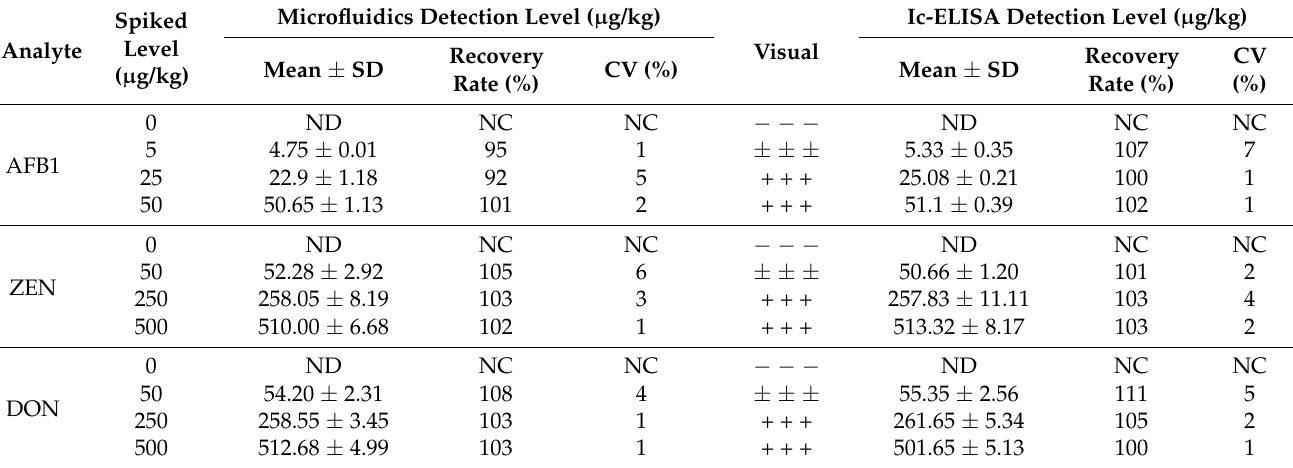
Table 3. Comparison of microfluidic and ic-ELISA spiked recovery ( n = 3).